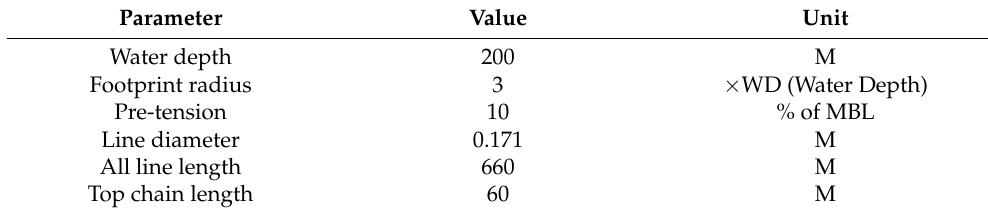
Table 5. Parameters for the mooring system design.